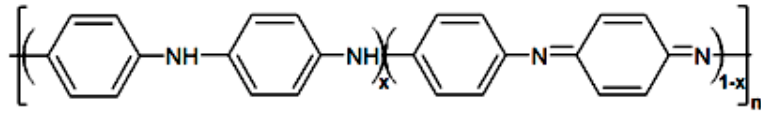
Figure 1. Molecular structure of polyaniline (PANI).